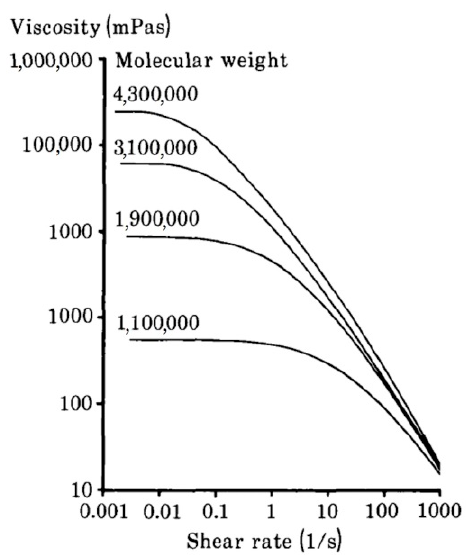
Figure 6. The effect of the molecular weight of hyaluronic acid on dynamic viscosity depending on the shear rate for the polymer solutions at a concentration equal to 10 mg/mL Adapted from [50], with permission from Taylor & Francis, 2020.